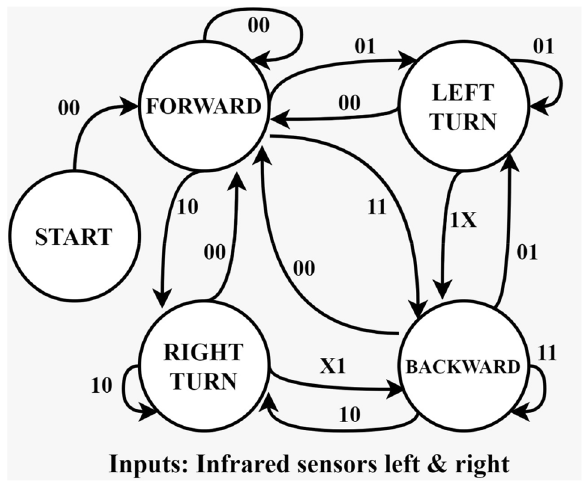
Fig. 5 FSM of robot´s behavior path